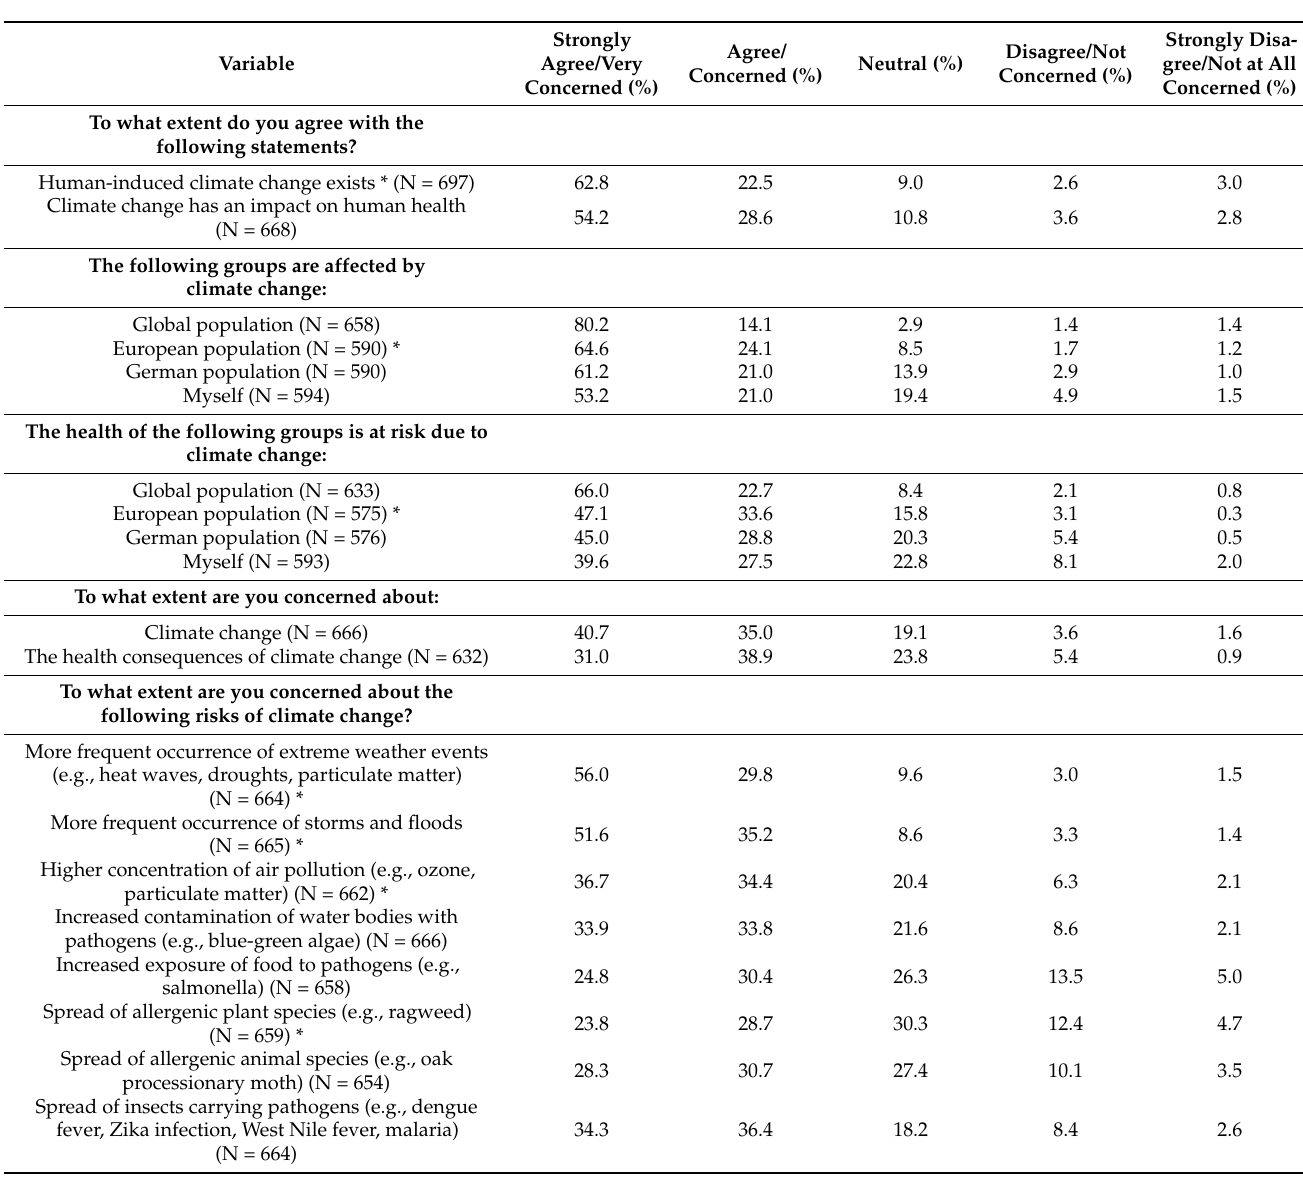
Table 2. Perceptions of climate change and its health consequences (N =